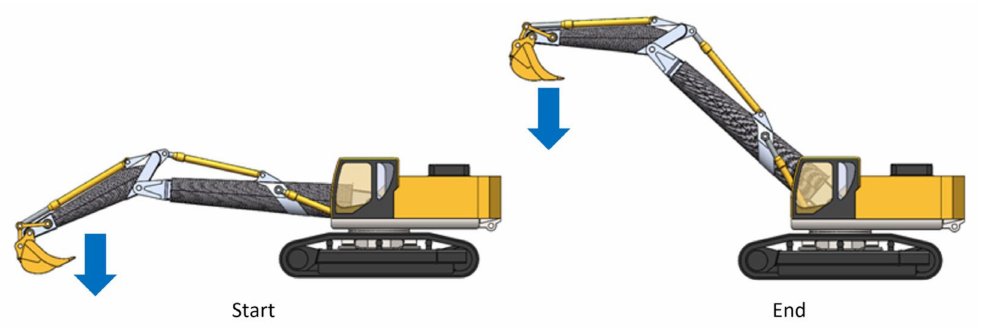
Figure 4. Load condition 3.